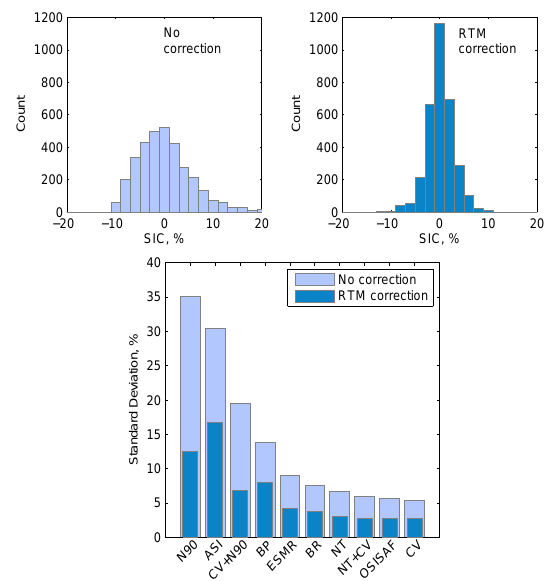
Figure 6. Histograms for SSM/I sea ice concentration (SIC) ob- tained by the OSISAF algorithm over open water (SIC = 0%) in the Northern Hemisphere in 2008 (entire year) without correction (upper panel, left) and with radiative transfer model (RTM) cor- rection (upper panel, right). The histograms contain 21 bins of 2% SIC. Bottom panel: decrease in standard deviations for 10 SIC algo- rithms due to the atmospheric correction of the measured brightness